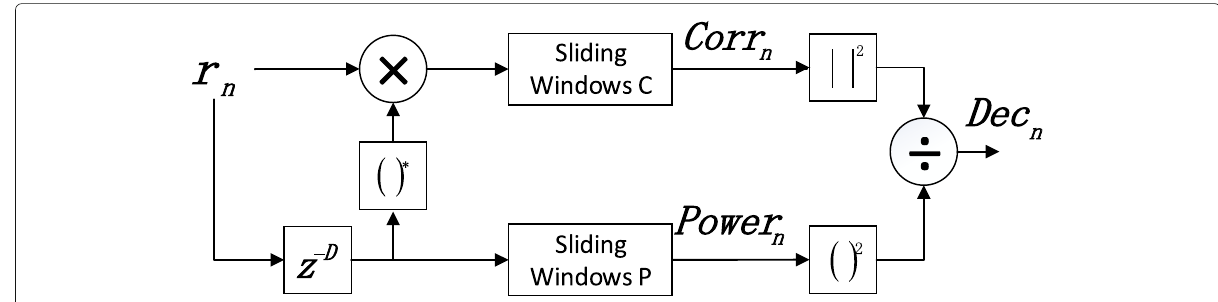
Fig. 2 Signal flow structure of the delay and correlate